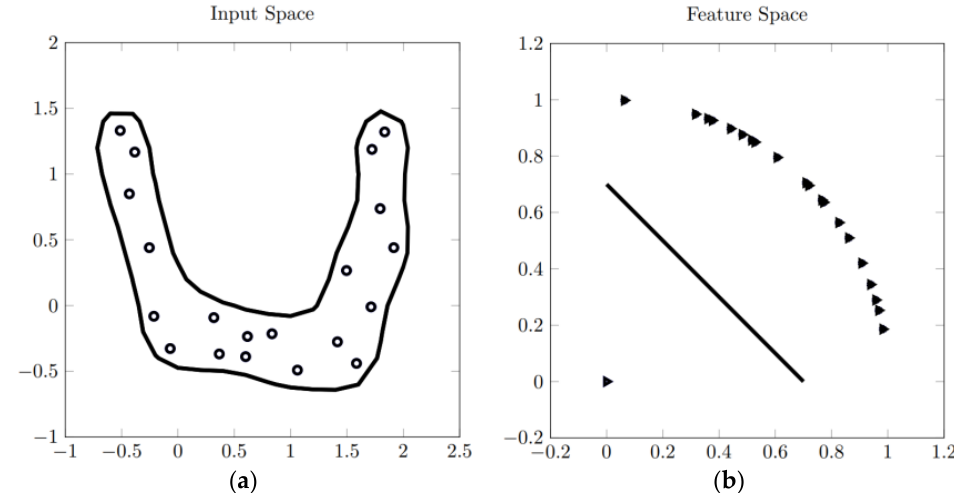
Figure 1. Toy example to illustrate OCSVM. The left plot shows the input data points and the nonlinear learned support of the data. The right plot shows the points mapped in a certain feature space induced by a kernel function and the linear classifier that separates the mapped points from the zero vector in feature space.